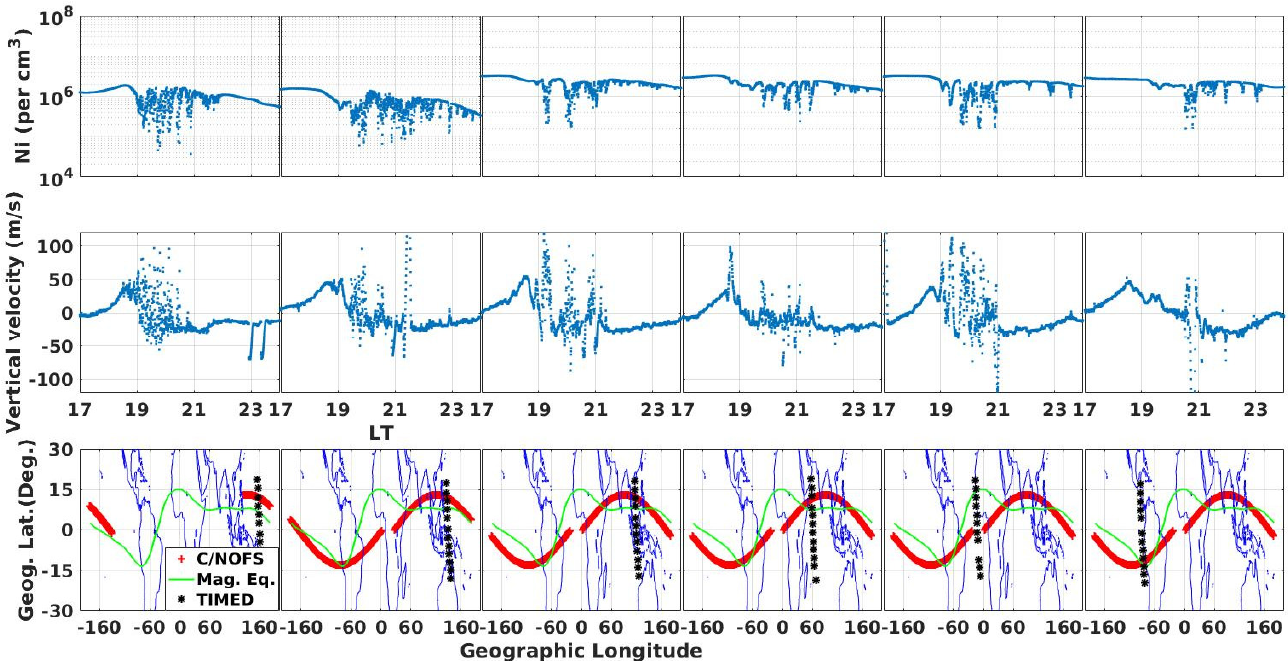
Figure 1. Irregular ion density ( top row ) and plasma vertical drift velocity ( middle row , positive and negative values represent upward and downward, respectively) from C/NOFS and coordinates of data from C/NOFS and SABER satellites ( bottom row ) versus LT on 15 October 2011.